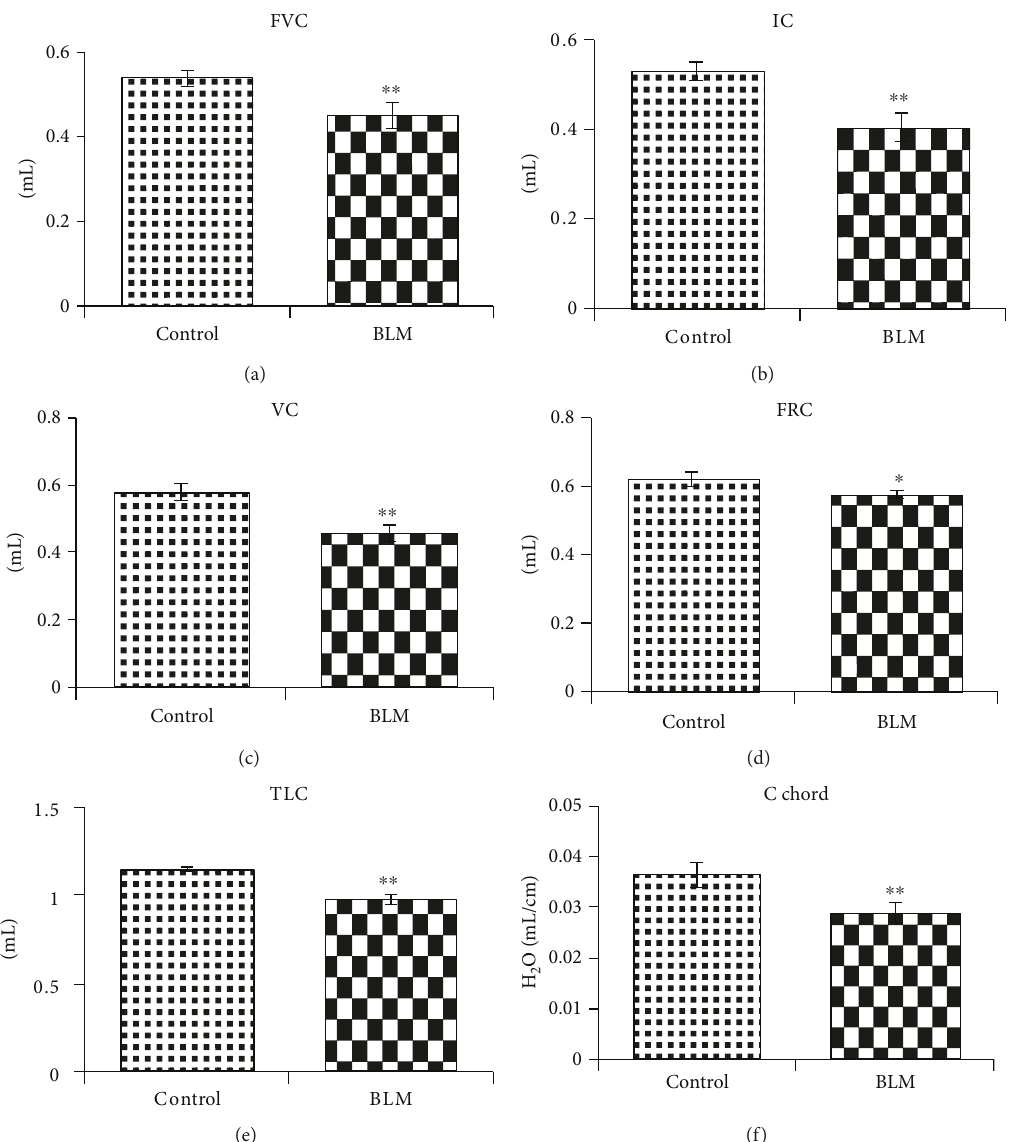
Figure 2: Lung function was reduced in mice with BLM-induced fi brotic lungs. Anesthetized mice were endotracheally intubated with an airway catheter, and the parameters of lung function were measured by a pulmonary function testing system. (a) FVC (forced vital capacity), (b) IC (inspiratory capacity), (c) VC (vital capacity), (d) FRC (functional residual capacity), (e) TLC (total lung capacity), and (f) C chord (lung compliance). The quantitative data were expressed as the means ± SD . Light spots represent the lung function of control mice ( n = 4 ), and dark spots represent the lung function of mice with BLM-induced lung injury ( n = 5 ). ∗ p < 0 05 and ∗∗ p < 0 005 compared with control